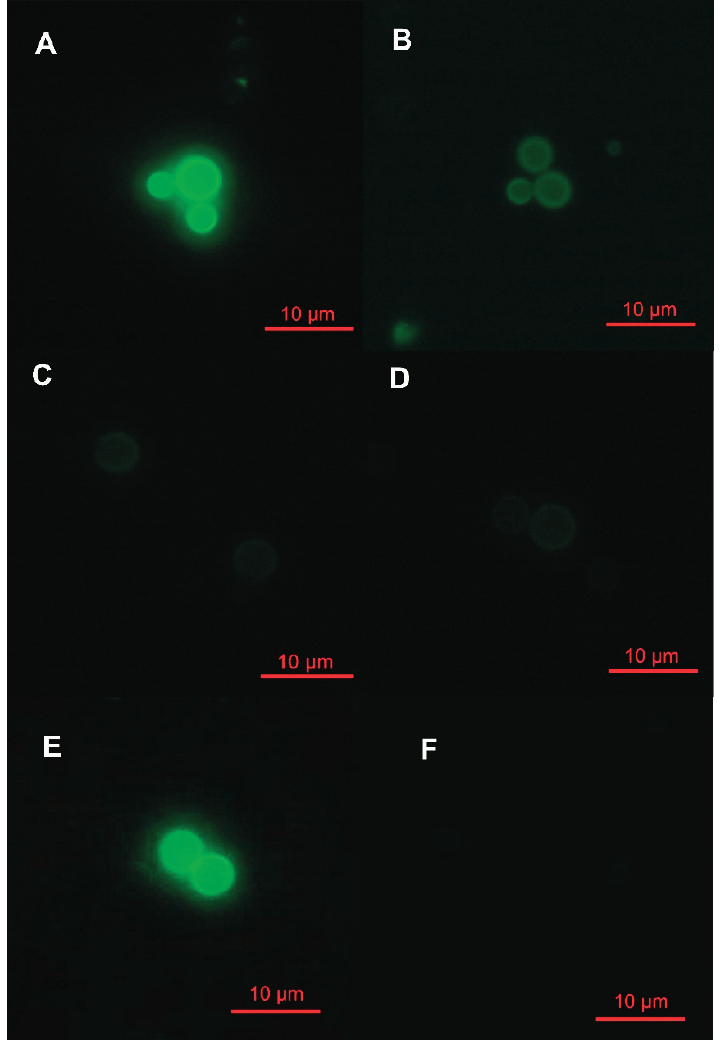
Figure 1. Fluorescence patterns of lectin staining from clinical isolates of Cryptococcus neoformans var. grubii . The staining was intense ( A ) with wheat germ agglutinin (WGA), moderate ( B ) with concanavalin A (Con A), and weak ( C , D ) with peanut agglutinin (PNA) and Ulex europaeus agglutinin I (UEA-I). Positive ( E ) and negative ( F ) controls of the fluorescence